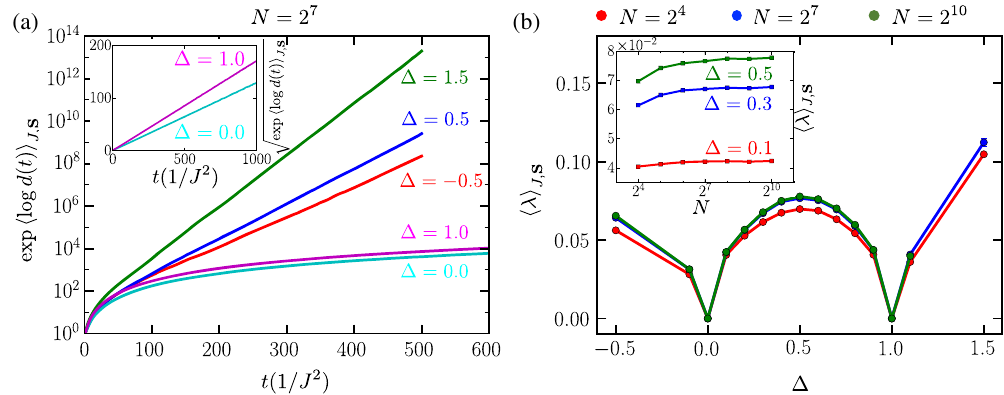
and initial states f S ð 0 Þg as a i g averaged over 10 5 J; S as a function of the J; S